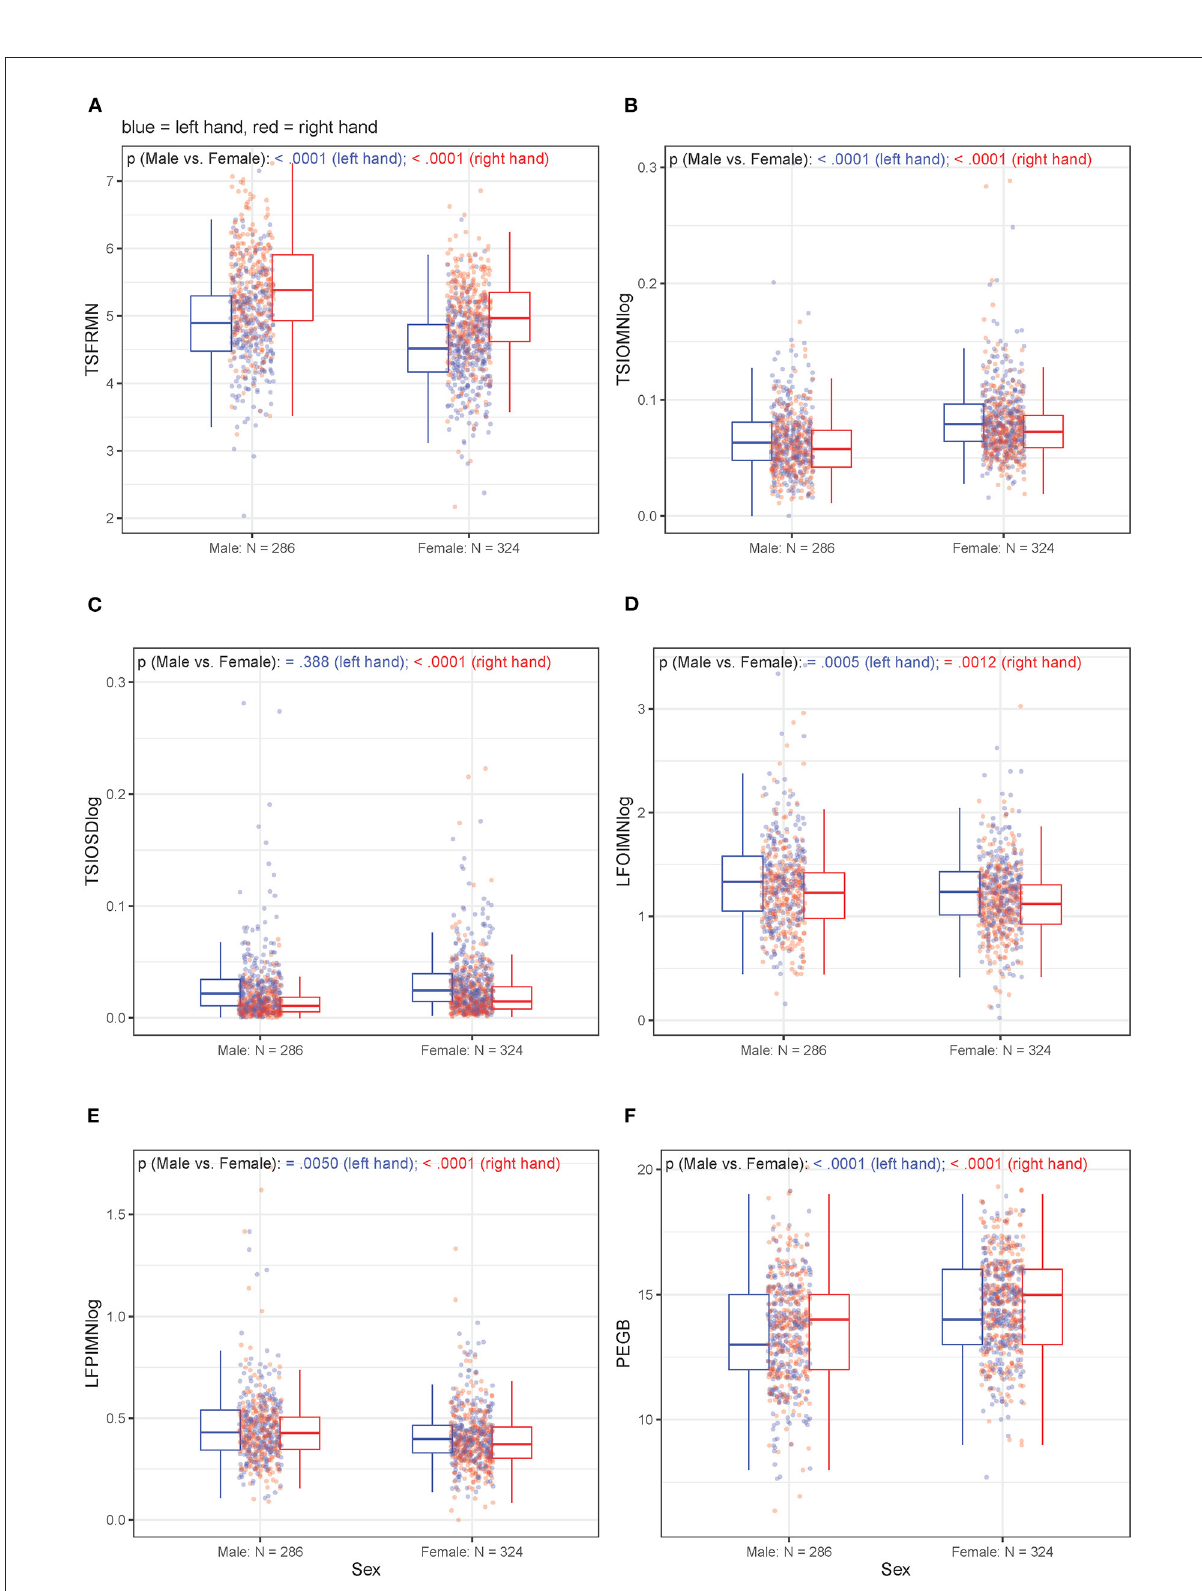
FIGURE4 (A–F) Unadjusted, bivariate associations between sex and the motor outcomes in right-handed participants for left and right hands